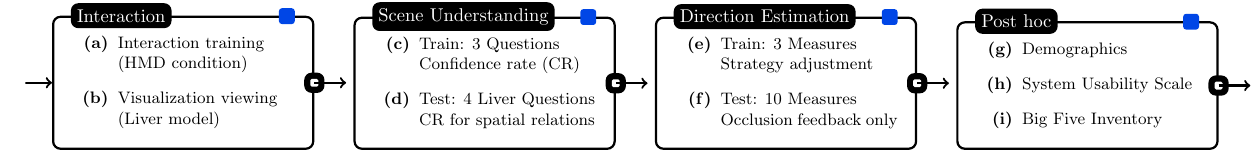
Figure 2. Example procedure for HMD-Liv group ( ). A participant P is assigned to view the Liver model in the HMD condition. ( a ) P learns how to interact with a demo model. ( b ) Then when viewing the assigned model, P is told that the sphere is the target. During Task 1: Scene Understanding Task , ( c ) A Multiple Choice Test (MCT) is used for confidence training. Correct answers to training questions are given and P is asked to reconsider strategy for Confidence Rating (CR). ( d ) Testing follows without feedback. During Task 2: Direction Estimation Task A Polaris tracking system is used to track P and the model of interest. ( e ) A tracked pointing tool is used to point at a point of entry (PoE) on the Liver printed model. P approaches the printed model as it is seen in the initial view in the visualization of the model in ( b ). Upon occlusion, P is asked to review the strategy (training only) ( f ) In testing, P restarts from the initial view to record all PoE with occlusion feedback only. ( g ) The demographics part included (Gender, age, etc). ( h ) Two System Usability Scale (SUS): one for the interaction in the HMD condition in which P interacted with the Liver model visualization, and another for the pointing/tracking system in which P interacted with the printed Liver model. ( i ) The Big Five Inventory